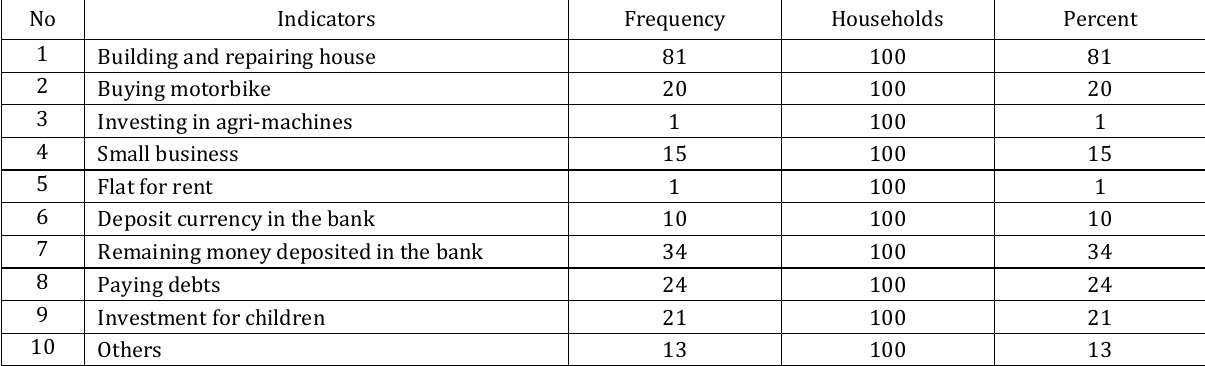
Table 4. The main ways that compensation payments were used (Source: Households' survey, 2020) No